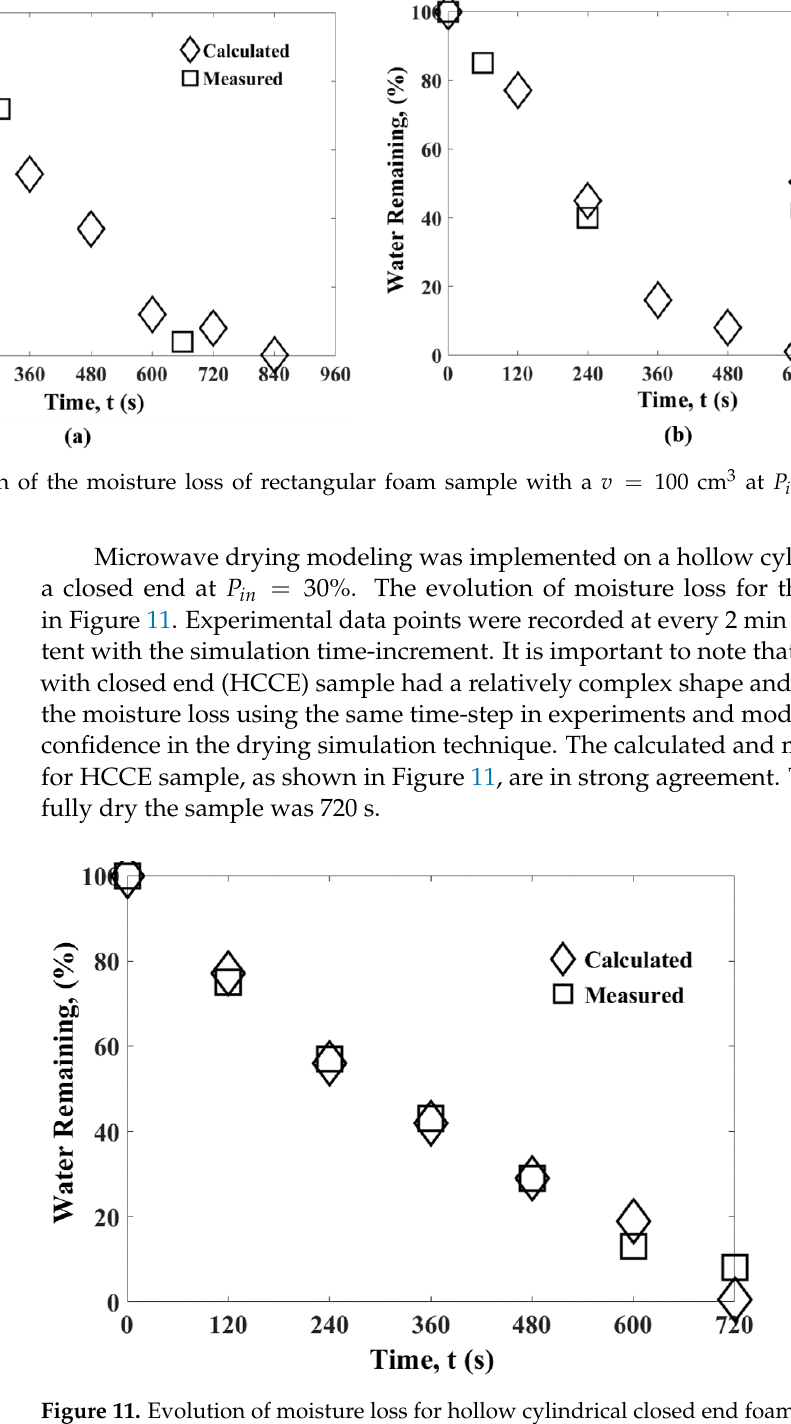
15 of 19 Figure 9. Comparison of the moisture loss of cylindrical foam with a 𝑣 = 100 cm 3 dried at 𝑃 𝑖𝑛 = 30% (𝐚) and 𝑃 𝑖𝑛 = 70% (𝐛) .